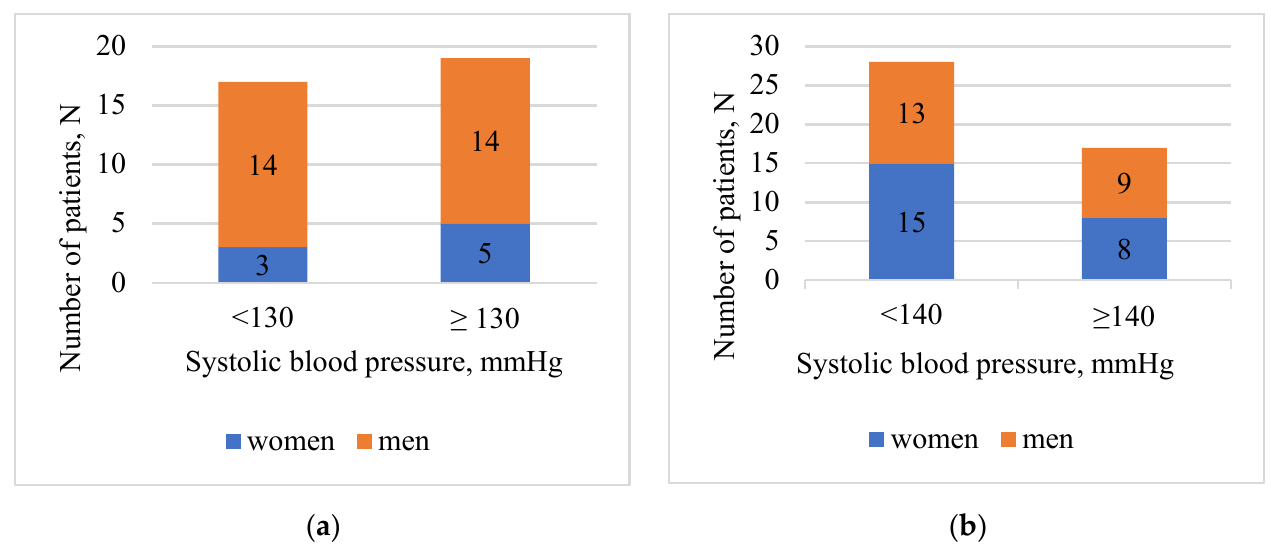
Figure 1. Hospital systolic blood pressure depending on the target blood pressure in the relevant age group. ( a ) Age group <65 years. ( b ) Age group ≥ 65 years.